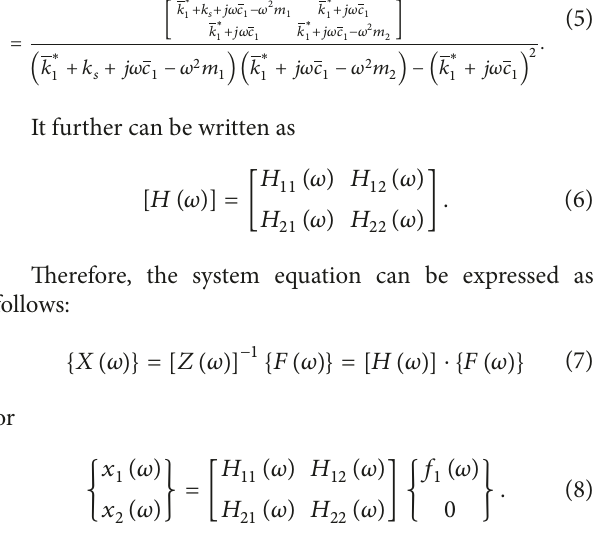
Figure 3. Taking the axial symmetry of the model into consideration, and meanwhile supposing that the stiffness and damping provided by the spring and damper in the 𝑦 direction can be merged into those in the 𝑥 direction, we can thus obtain a more simplified system model in which the mechanical behaviors in the 𝑥 direction and in the 𝑦 direction are decoupled, as shown in Figure